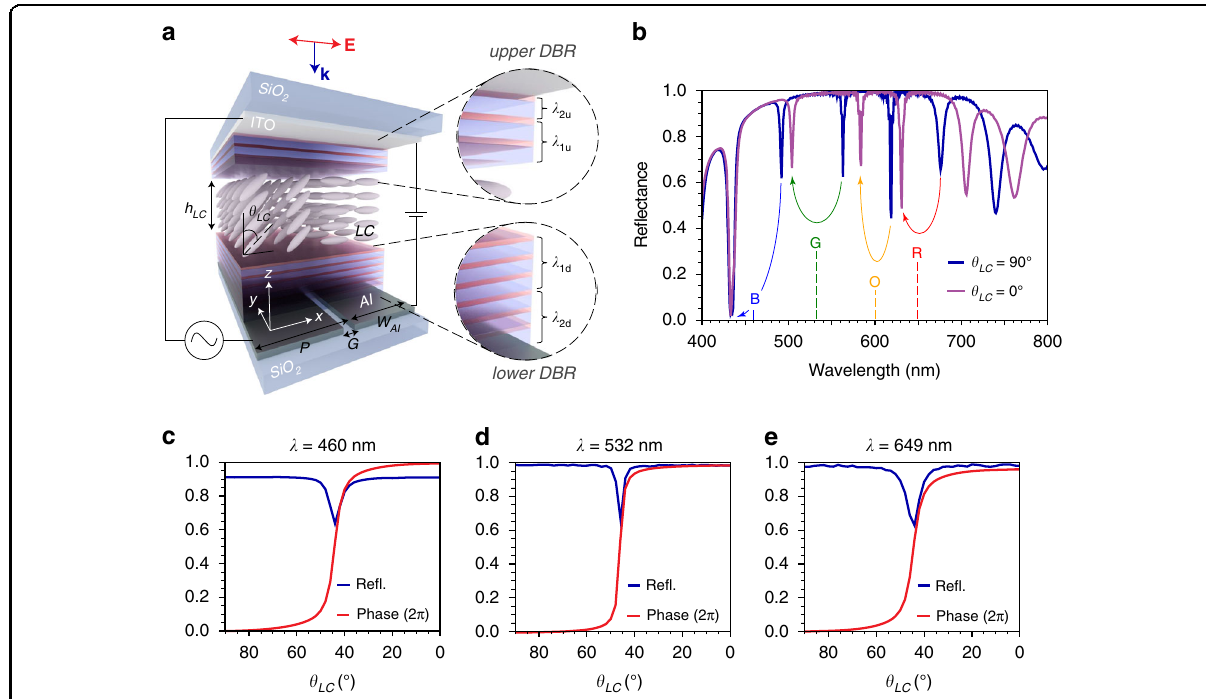
Fig. 1 Concept of FP-SLM. a The schematic of the FP-SLM showing two pixels. The system comprises two partially re fl ecting mirrors, denoted as upper and lower DBR, a top ITO layer acting as a common electrode, a LC layer with thickness h LC and a set of Al electrodes forming pixels with a width w Al , periodicity P and inter-pixel gaps G , as speci fi ed in the main text. When bias is applied between an Al electrode and the top ITO electrode the orientation of the LC director on top of the pixel can be modi fi ed from its initial in-plane state ( θ LC = 90°) to a certain tilted angle θ LC . b Simulated re fl ectance spectra for two different LC orientation angles, θ LC = 90° and 0°, for the non-pixelated FP-SLM with h LC = 750 nm. The dashed vertical lines represent the operating wavelengths, while the color arrows are guides to the eye indicating the initial and fi nal positions of the resonances. c – e Simulated re fl ectance and phase shifts at the operating RGB wavelengths versus the LC rotation